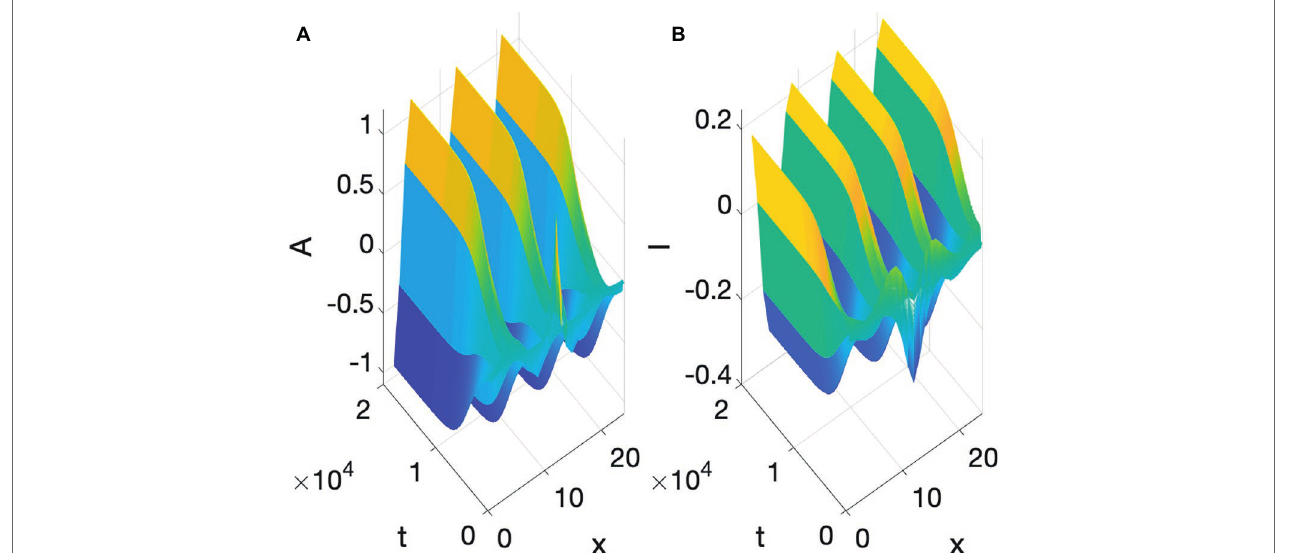
FIGURE 3 | Turing pattern formation: (A) Activator, (B) Inhibitor.